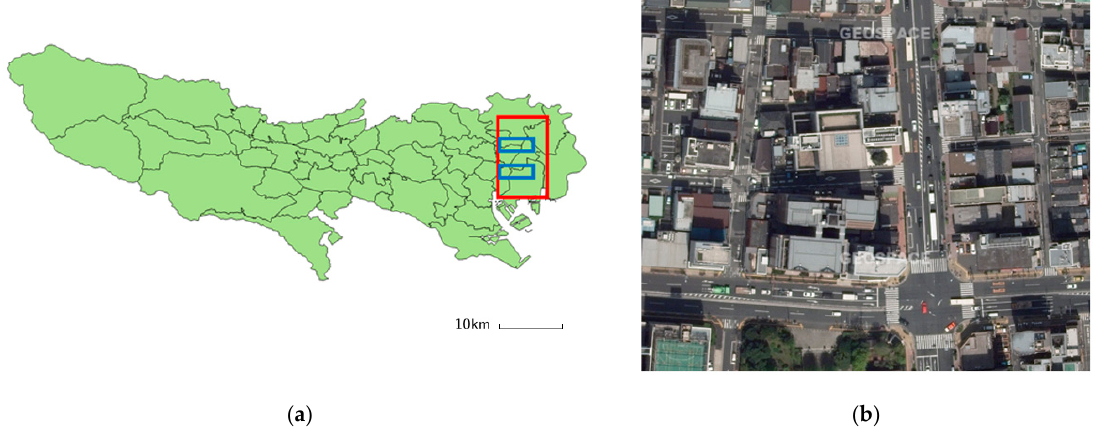
Figure 5. Study area in Japan. ( a ) Map of Tokyo. The red rectangle outlines the study area for which aerial images were obtained. We extracted non-labeled training images for DA from the area outlined by the blue rectangles and labeled training and test images from the area outlined by the red rectangle (excluding the blue rectangles) where the latter images were manually annotated. ( b ) An example image.